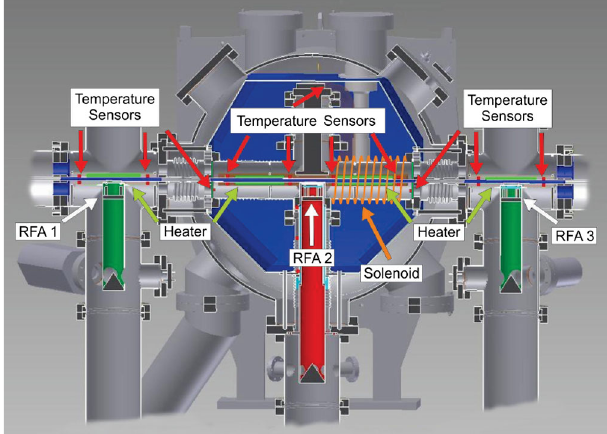
FIG. 8. Overview of the installed diagnostics devices in